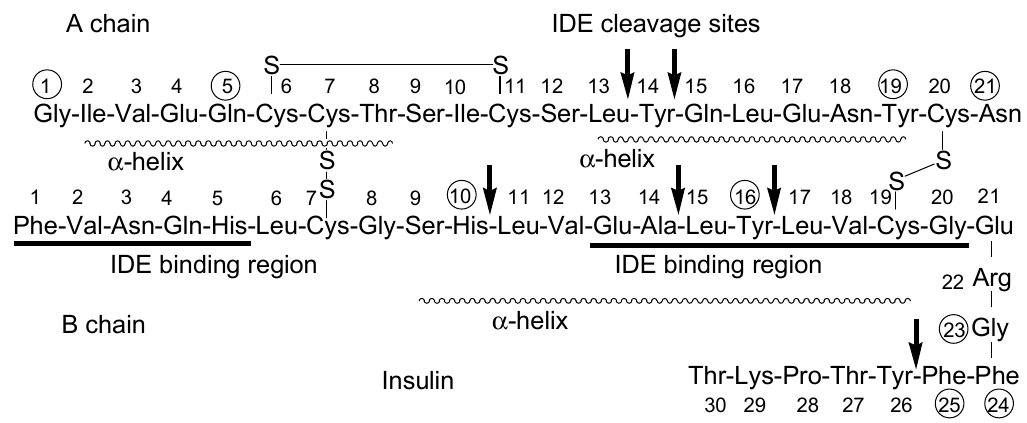
Figure 4. Structure of human insulin. Arrows indicate IDE cleavage sites. IDE binding regions are underlined. Circled numbers indicate amino acids involved in insulin receptor (InsR) binding. α -Helix regions are indicated with broken lines. IDE stands for insulin-degrading enzyme.